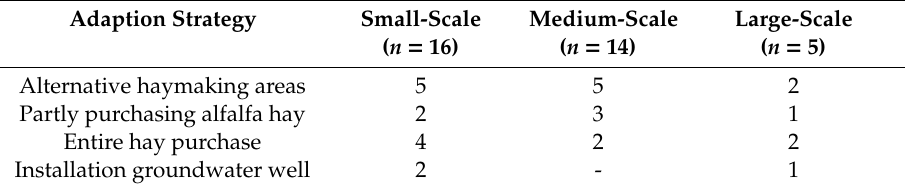
Table 7. Short-and medium-term adaption strategies implementation in 2015 by three types of individual farms in response to reduced water inflow to the Ili